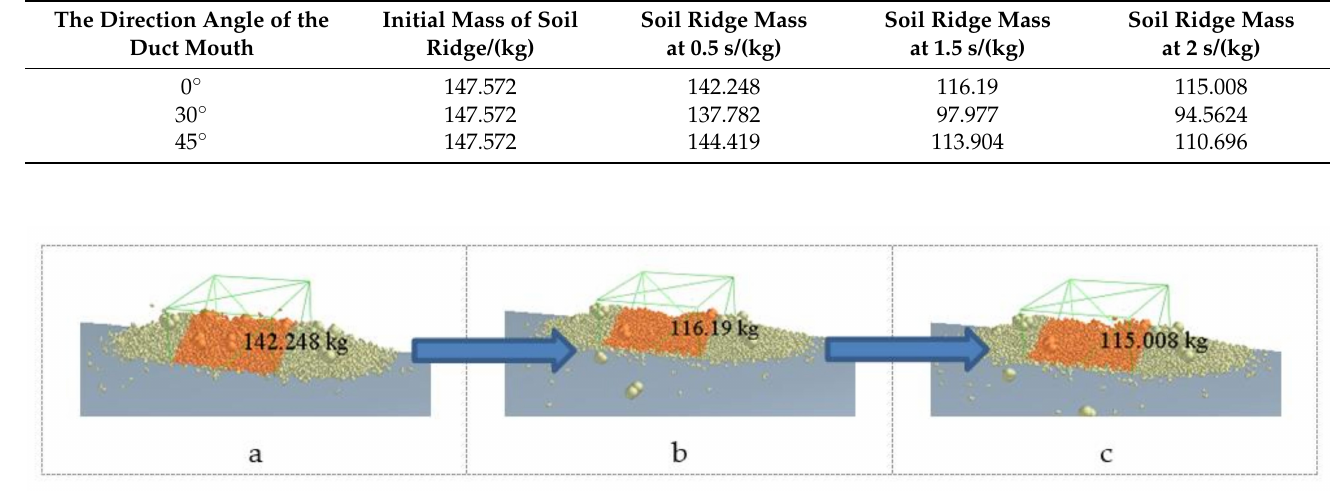
Figure 14. Simulation process of airduct mouth direction angle, 0 ◦ . ( a ) soil ridge mass at 0.5 s/(kg), ( b ) soil ridge mass at 1.5 s/(kg), ( c ) soil ridge mass at 2 s/(kg).